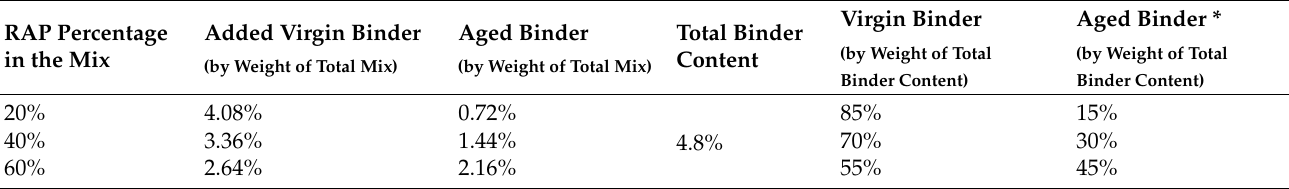
Table 18. The added percentages of virgin binder to the recycled mixtures.